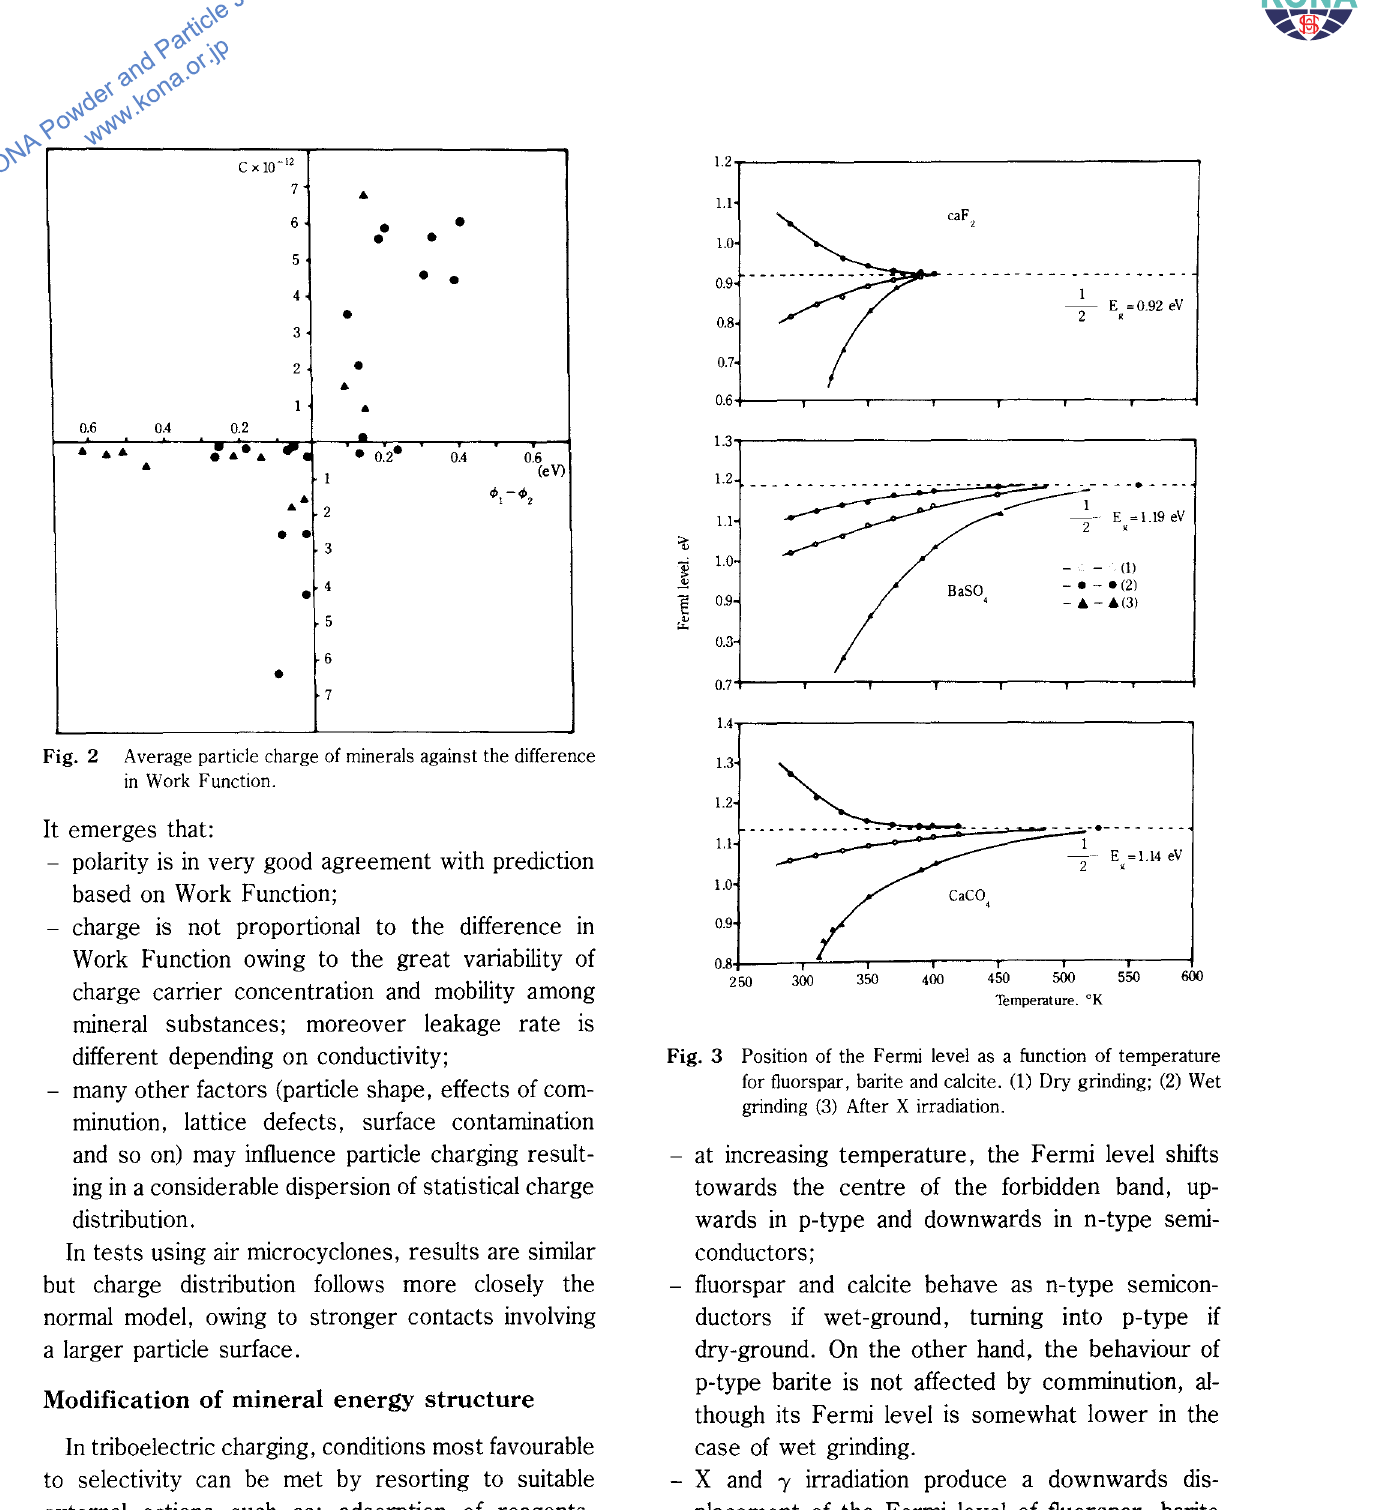
Average particle charge of minerals against the difference in Work Function.